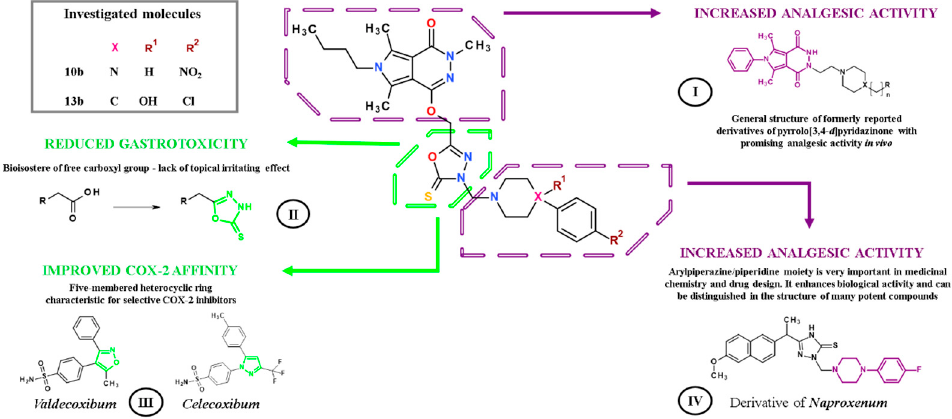
Figure 8. The design concept of the novel pyrrolo[3,4- d ]pyridazinone derivatives.